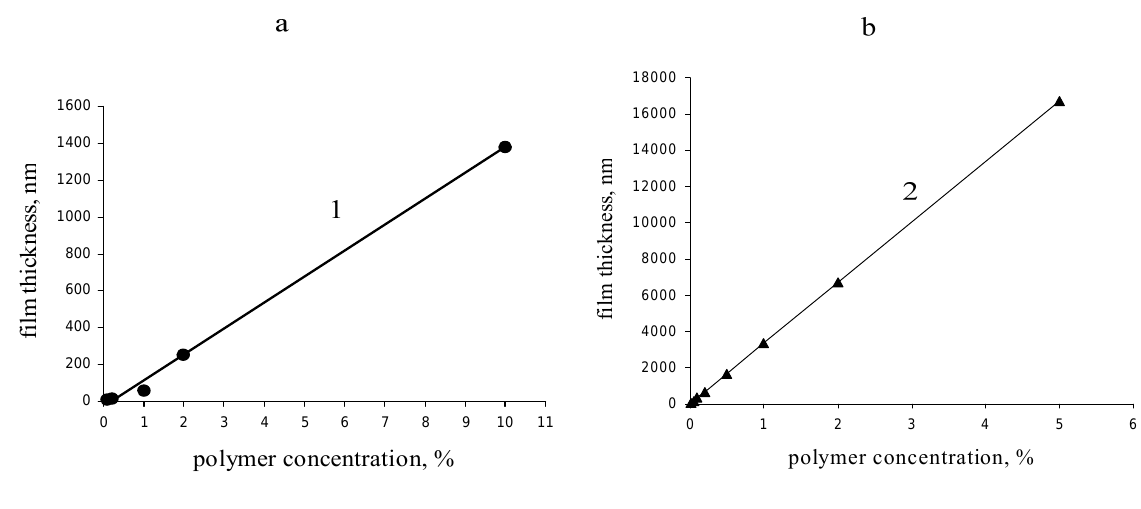
Figure 2. Film thickness as a function of polymer concentration used and processing conditions applied. (a) Film prepared by spin coating; film thickness measured by ellipsometry (1). (b) Film prepared by spraying and thickness estimated from the sprayed volume assuming that the polymer density is 1 g/cm 3